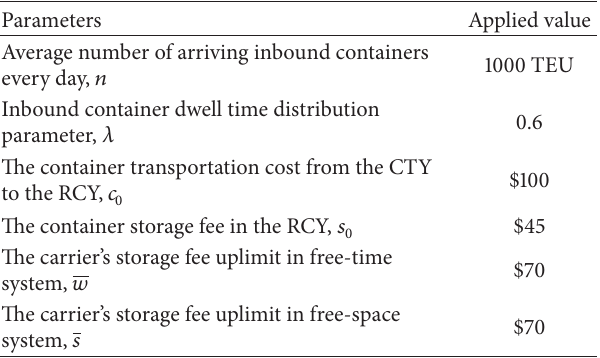
Table 1: Parameters setting for numerical